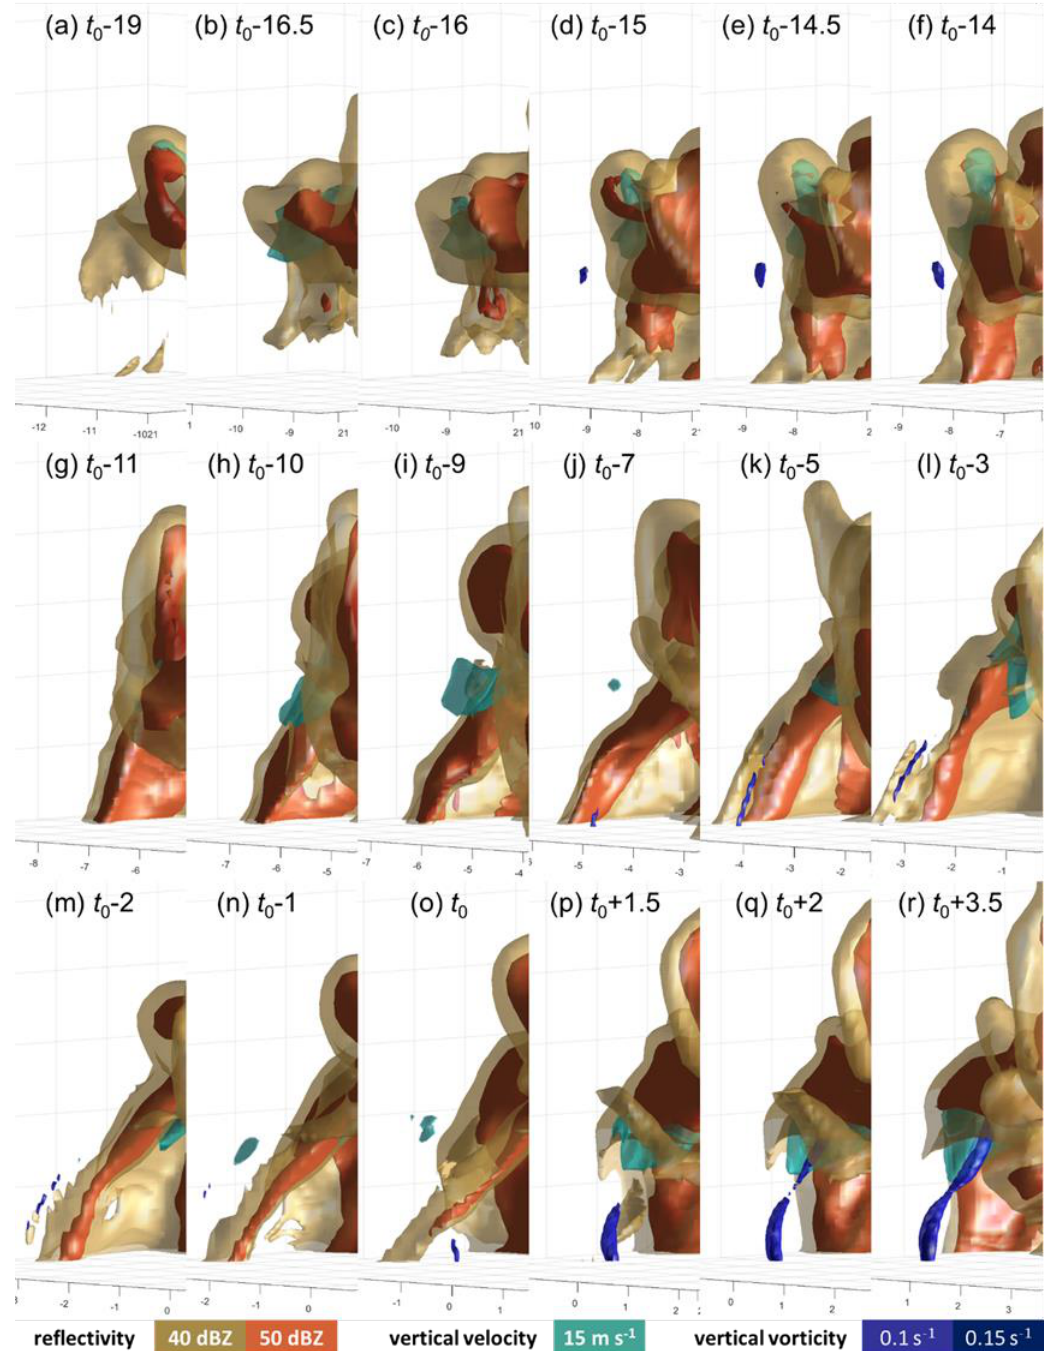
Figure 5. Simulated three-dimensional supercell structure in terms of reflectivity, vertical velocity and vertical vorticity from ( a ) t 0 – 19 min to ( r ) t 0 + 3.5 min at specific times as denoted. The tornadic supercell is during the period of DRC formation and tornadogenesis. The isosurfaces of 0.1 s −1 and 0.15 s −1 vertical vorticity are given in dark blue. The updraft of the mesocyclone of 15 m s −1 is shown in cyan. The isosurfaces of 40 and 50 dBZ reflectivity are given in brown and red, respectively.